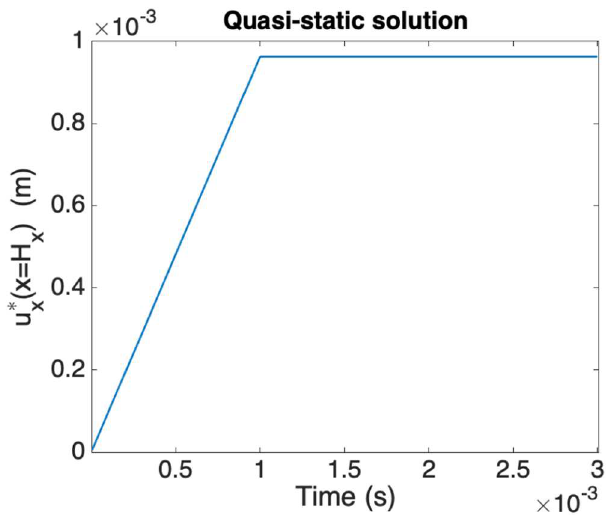
Fig. 9. Averaged displacement of the structure right surface: u ∗ x ( x = H x )